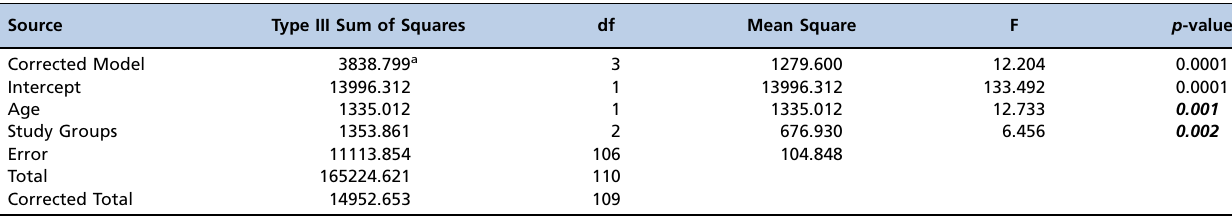
Table 5 - Contrast hypothesis results between study groups as patients with prediabetes vs . controls (Level 2 vs . Level 1) and patients with type 2 diabetes vs . controls (Level 3 vs . Level 1). Study Groups Simple Contrast